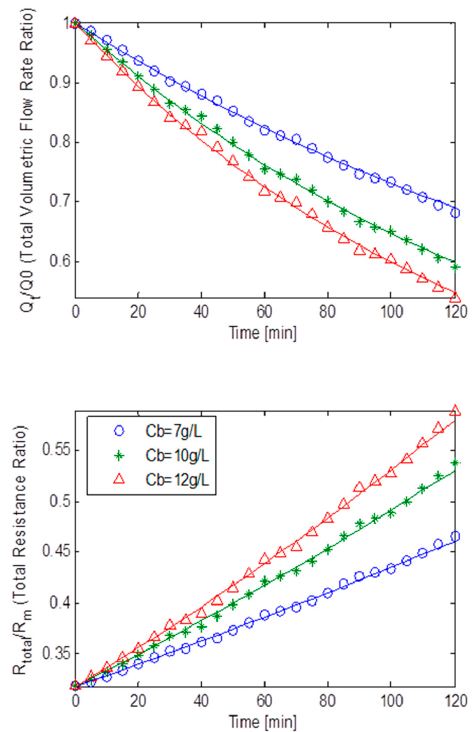
Figure 8. Flux decline and total resistance data obtained from pilot MBR plant located at Coors (UK) with best model fits.